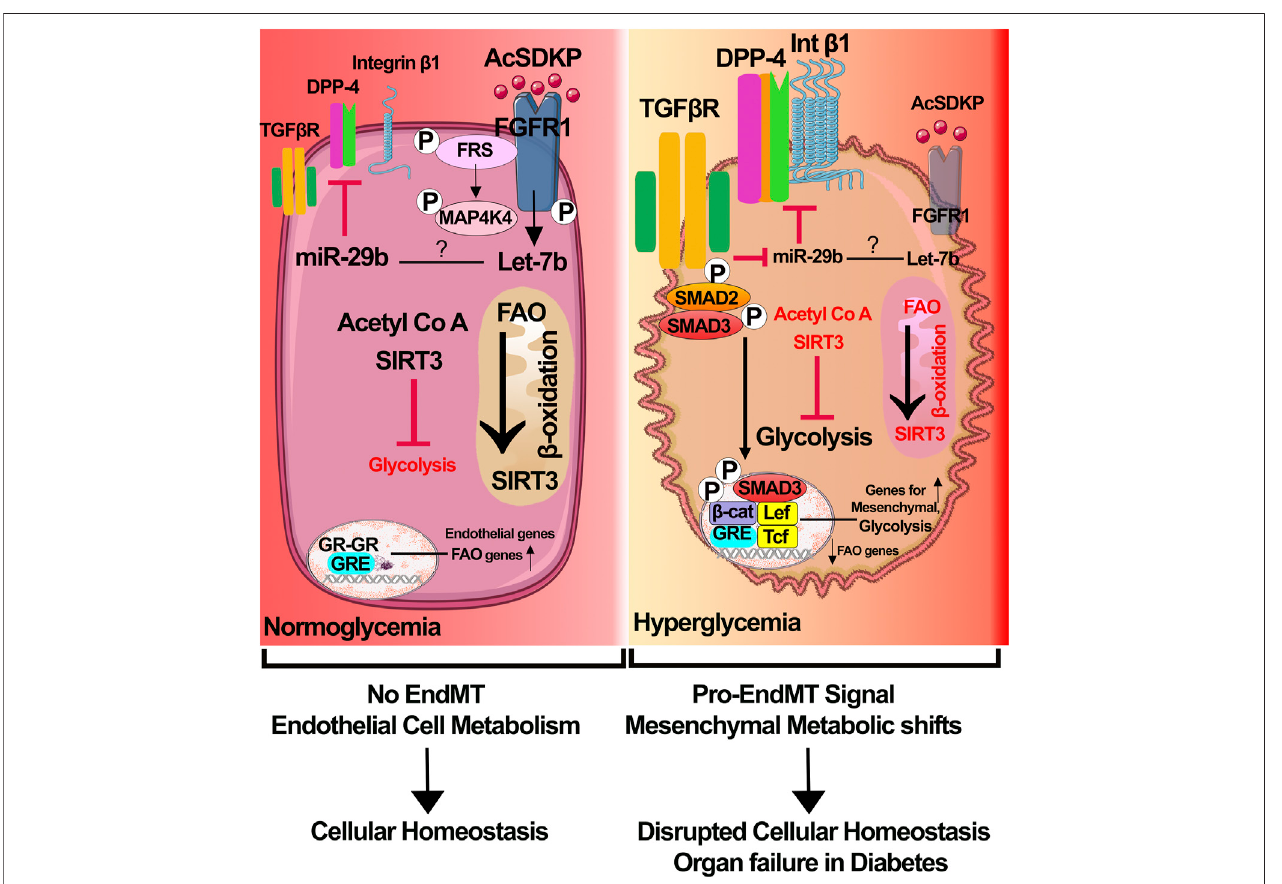
FIGURE 1 | Receptor dysfunctions and metabolic myo fi broblasts shifts in diabetic endothelial cells. In healthy endothelial cells, 1) physiological level of N-seryl- acetyl-lysyl-proline (AcSDKP)/ fi broblasts growth factor receptor 1 (FGFR1) interaction leads to activation of signaling cascade that is important for expression of anti- mesenchymalmicroRNAsmiR-29andmiR-let-7;2)sirtuins3(SIRT3),whichregulatesthelevelsoffattyacidoxidationinmitochondriaandglycolysisincytosol,balances the endothelial cell metabolism; and 3) glucocorticoid receptor is key for the transcription of endothelial genes and fatty acid oxidation genes. Cumulative effects contribute to endothelial cell health and homeostasis. In diabetic endothelial cells, 1) suppression of AcSDKP/FGFR1 interaction causes downregulation of expression levels of miR-29 and miR-let-7, which leads to the elevation in the levels of mesenchymal transforming growth factor receptor 1 (TGF β R1), dipeptidyl peptidase-4 (DPP- 4), and integrin β 1; 2) SIRT3 de fi ciency causes suppression in the fatty acid oxidation and induction in the aberrant glycolysis; GR de fi ciency results in activation of Wnt signaling, endothelial-to-mesenchymal transition processes and suppression in the level of fatty acid oxidation. Accumulative effects of all these lead to myo fi broblast metabolic reprogramming. Components of this fi gure were created using Servier Medical Art templates.